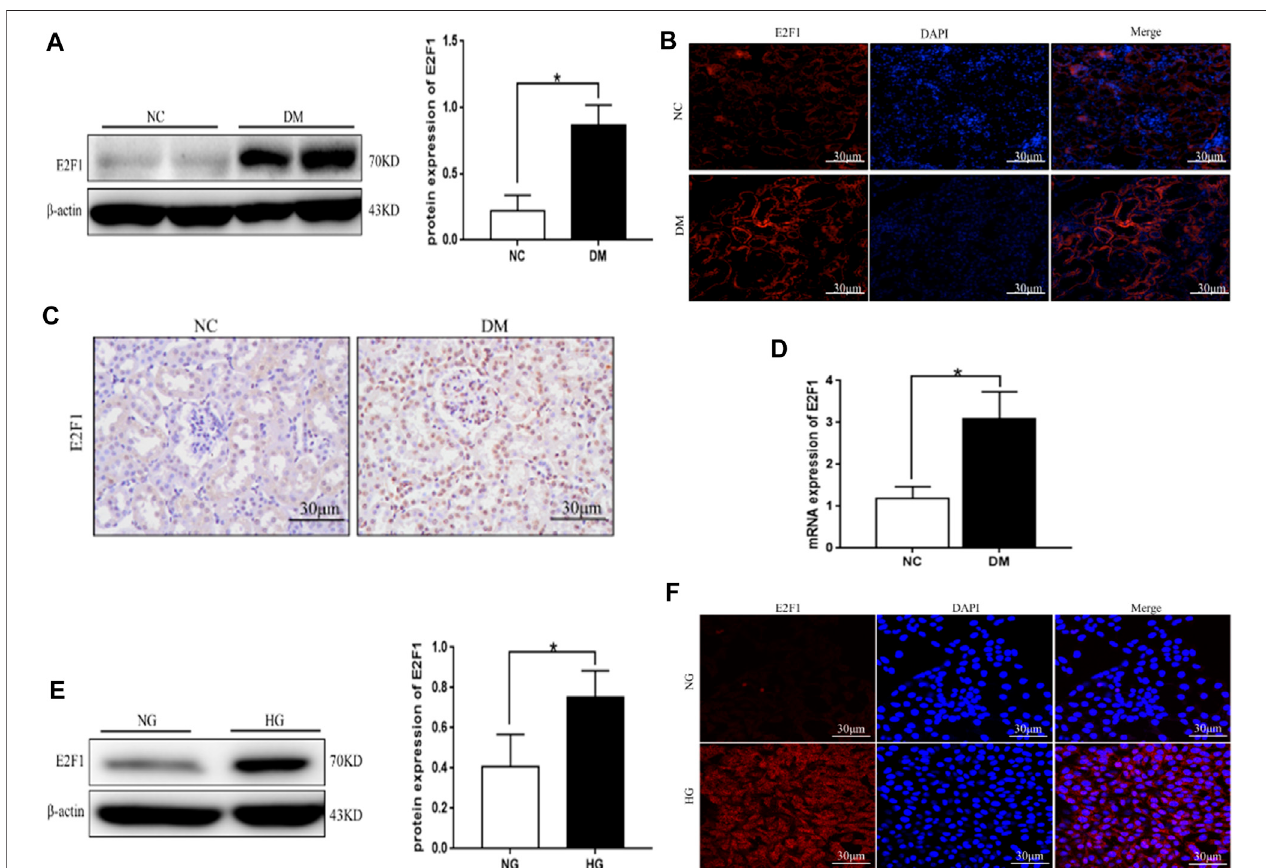
FIGURE 4 | High expression of E2F1 was observed in renal tubular epithelial cells in the high-glucose state. (A) Western blot analysis of E2F1 in the renal cortex of miceineachgroup(n=6,* p < 0.05vs.NC). (B) Tissueimmuno fl uorescenceofE2F1intherenalcortexofmiceineachgroup. (C) ImmunohistochemicalstainingofE2F1 intherenalcortexofmiceineachgroup. (D) Real-timePCRanalysisofE2F1intherenalcortexofmiceineachgroup(n=6,* p < 0.05vs.NC). (E) Westernblotanalysisof E2F1 in mRTECs (n = 3, * p < 0.05 vs. NG). (F) Cellular immuno fl uorescence of E2F1 in